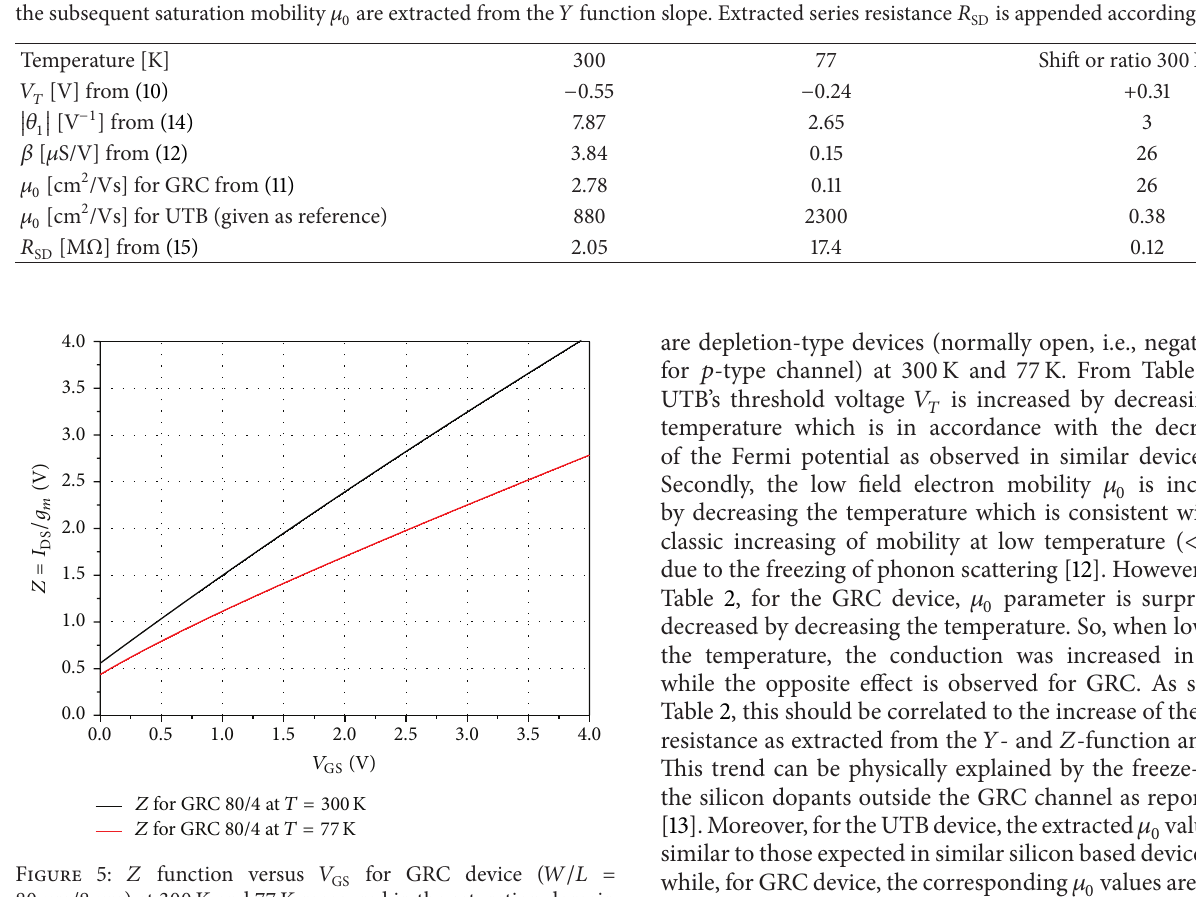
for GRC device ( 𝑊/𝐿 = GS